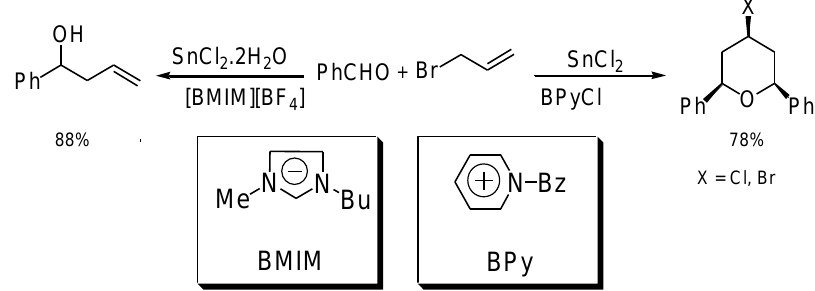
Scheme 2. Different products obtained under Barbier reaction conditions in ionic liquids.